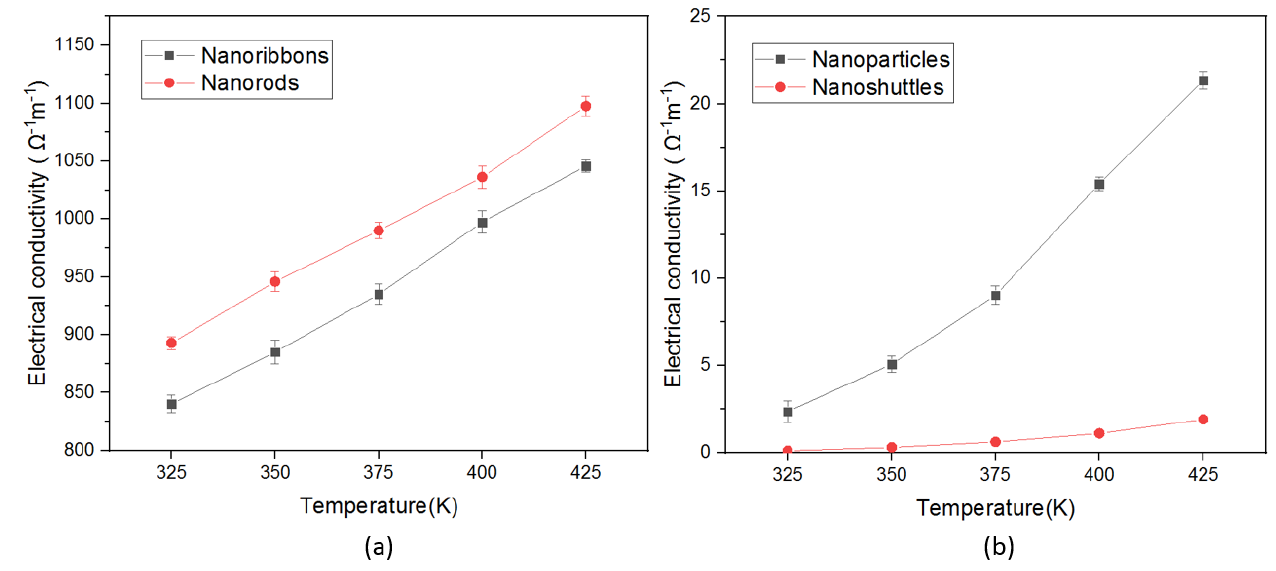
Figure 5. Temperature-dependent electrical conductivity of ZnO nanostructures ( a ) nanoribbons, and nanorods, ( b ) nanoparticles, and nanoshuttles.